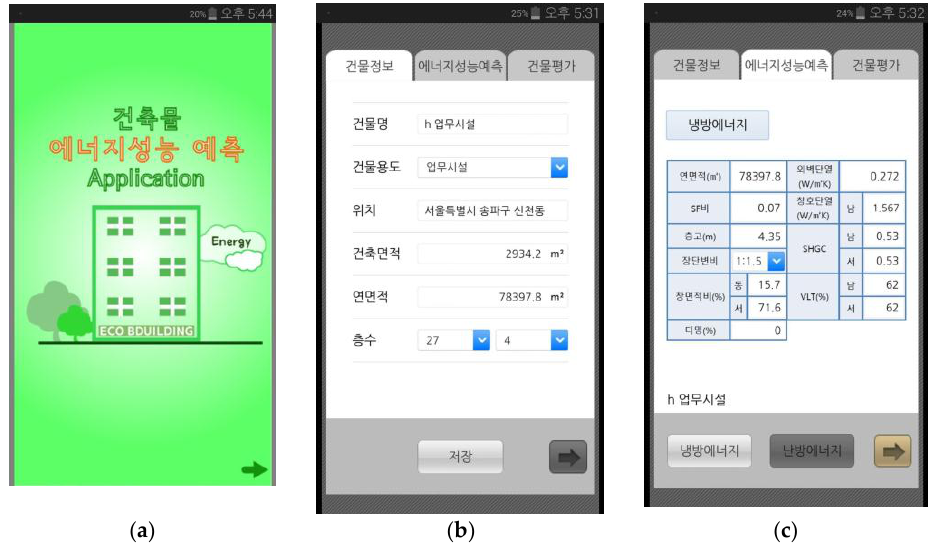
Figure 6. ( a ) Intro; ( b ) basic; and ( c ) information.